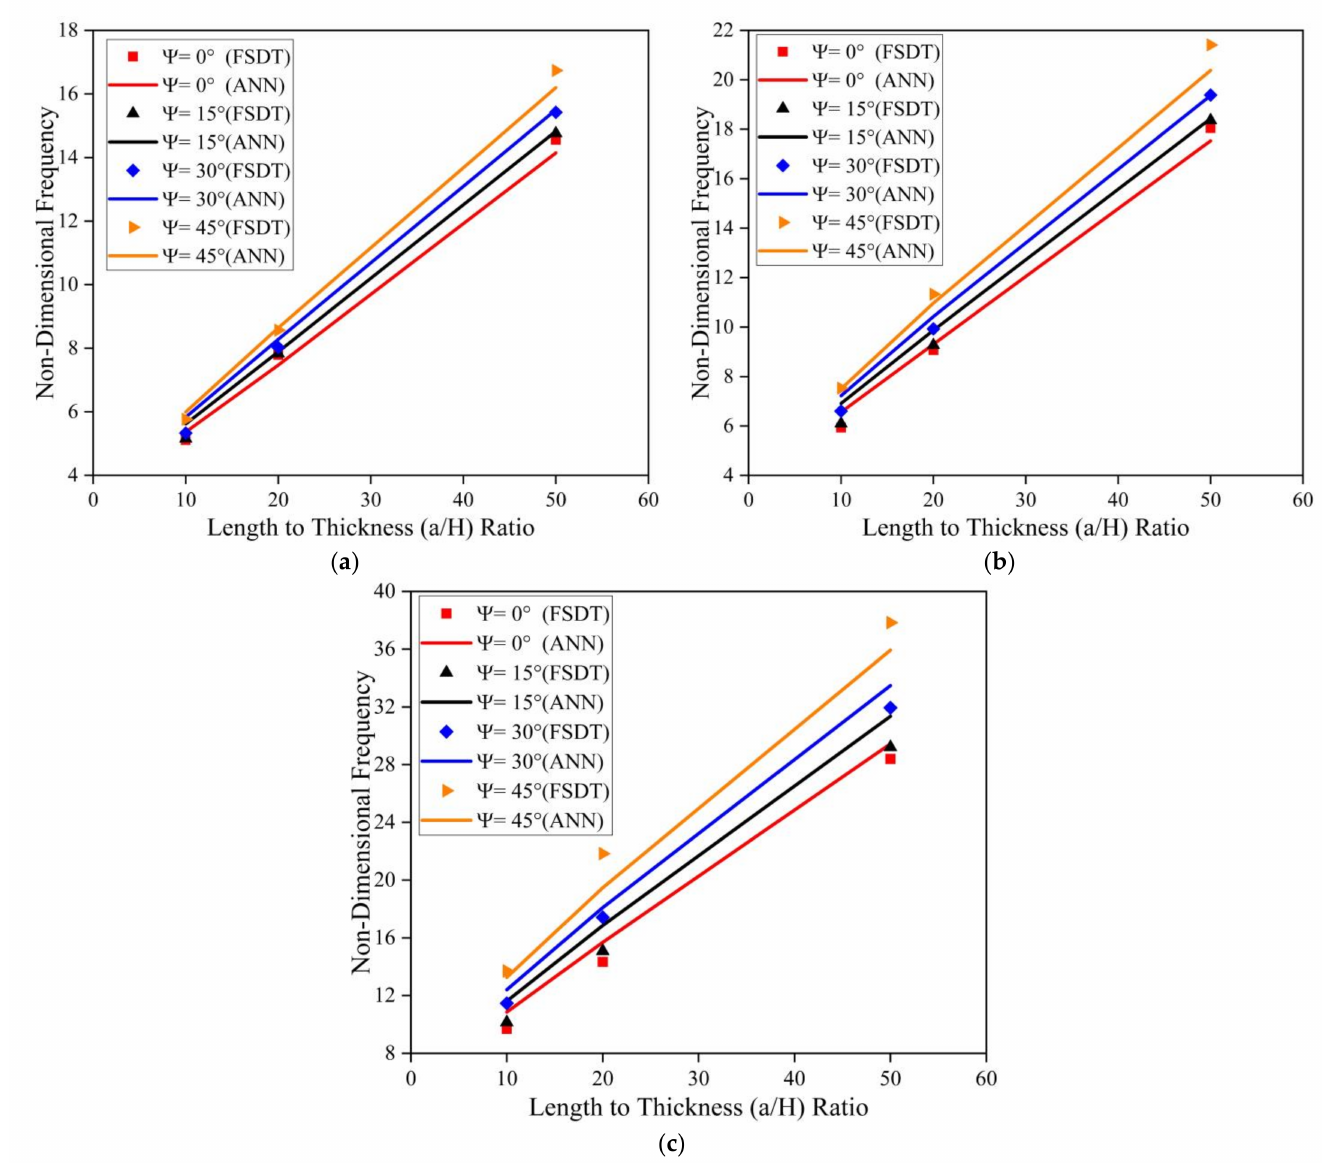
Figure 12. Influence of skew angle on the SSSS skew LCS plate in presence of moisture (0.25%) for varying a/b and a/H ratios ( a ) a/b = 0.5 ( b ) a/b = 1.0 ( c ) a/b =